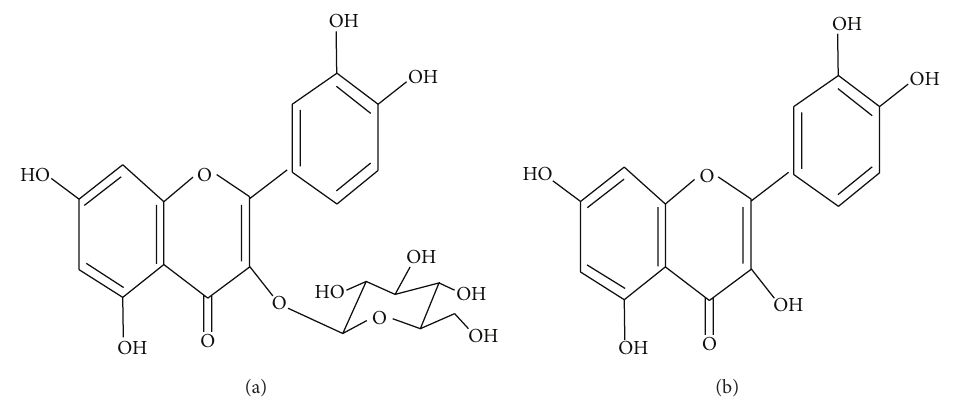
Figure 2: Structure of (a) flavonoid glycoside and (b) aglycone flavonoid.